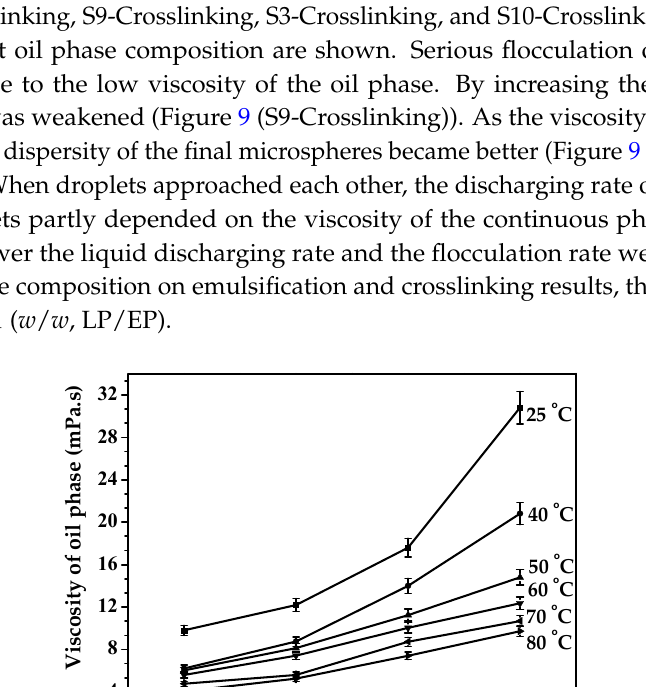
Figure 8. Viscosities of oil phase with different weight ratios of liquid paraffin to petroleum ether.